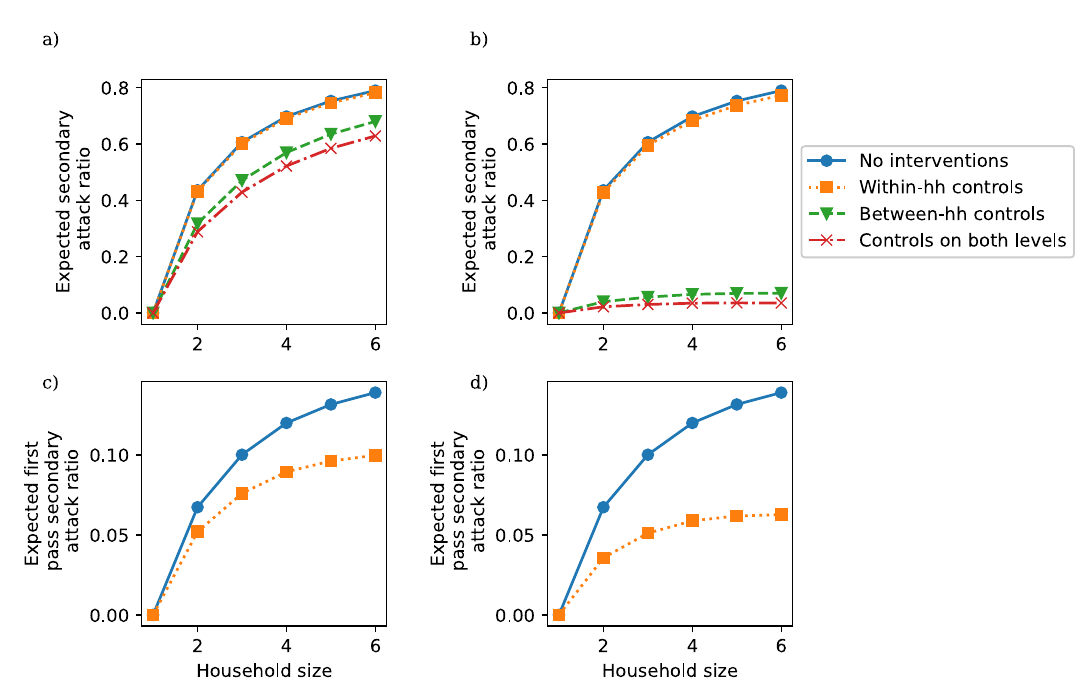
Fig 3. Expected secondary attack ratios by size. The first row gives the estimates from the full population dynamics with repeated imports of infection for a) a 25% reduction in transmission from each intervention, and b) a 50% reduction in transmission from each intervention; the second row gives the estimates from a single within-household outbreak without repeated imports of infection for c) a 25% reduction in transmission from each intervention, and d) a 50% reduction in transmission from each intervention.